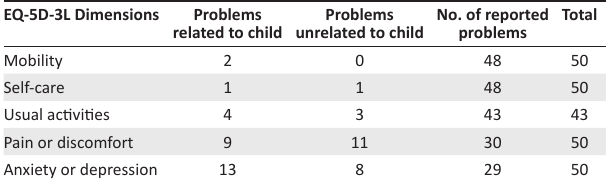
TABLE 5: Reasons behind the scoring of the EQ-5D-3L questionnaire on day 1. TABLE 3: Regression analysis of the caregiver’s EQ-5D-3L visual analogue scale